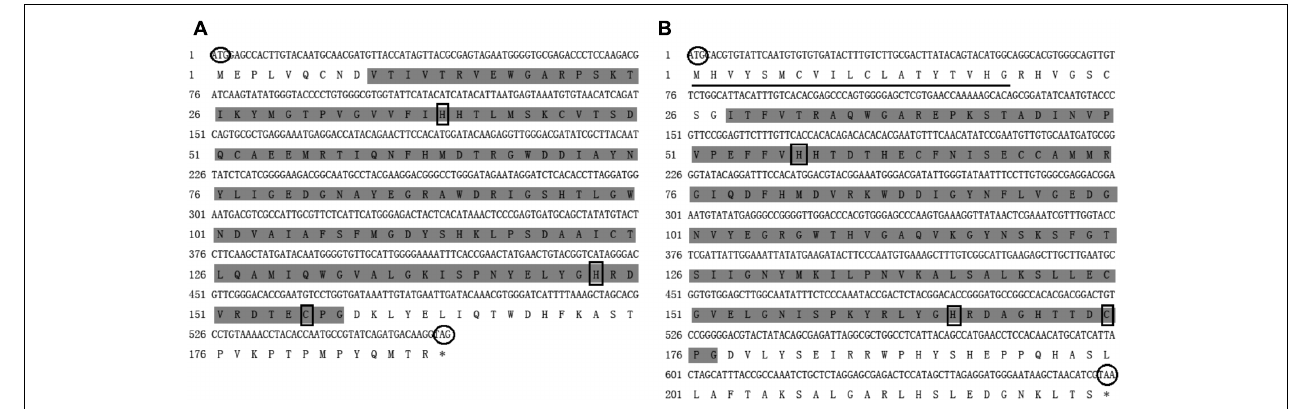
FIGURE 1 | Nucleotide and deduced amino acid sequences of ApPGRP-1 (A) and ApPGRP-2 (B) . The predicted signal peptide is underlined, and the predicted start and termination codons are circled. The amidase/PGRP domain predicted in SMART program is highlighted in gray, and the black boxes indicate Zn 2 + binding